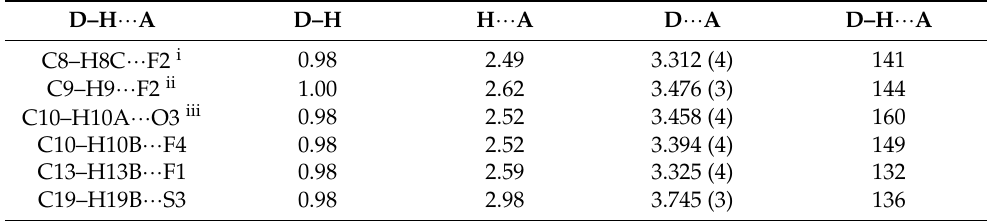
Table 5. Hydrogen-bond geometry (Å, ◦ ) for ( 3 ).